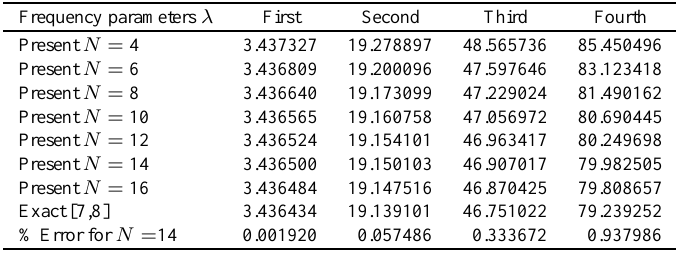
Table 2 Convergence pattern and comparison of frequency parameters for uniform Timo-